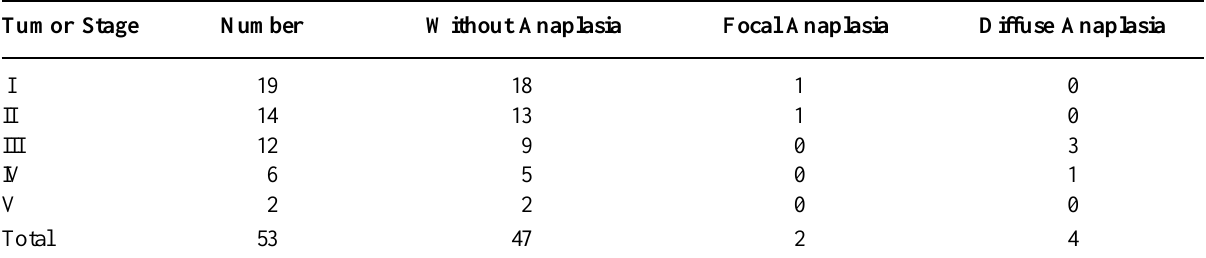
Table 1 – Distribution of Wilms’ tumors according to stage and histology. Tumor